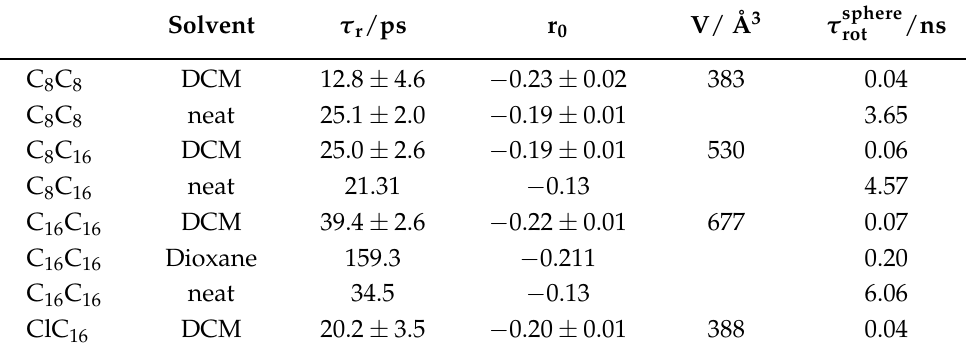
Table 5. Time-resolved anisotropy and the calculated rotational diffusion for a sphere with the same hydrodynamic volume in DCM, using η = 0.43 mPa · s for DCM, η = 1.2 mPa · s for dioxane, and values from Table 1 for the neat liquids. T = 293